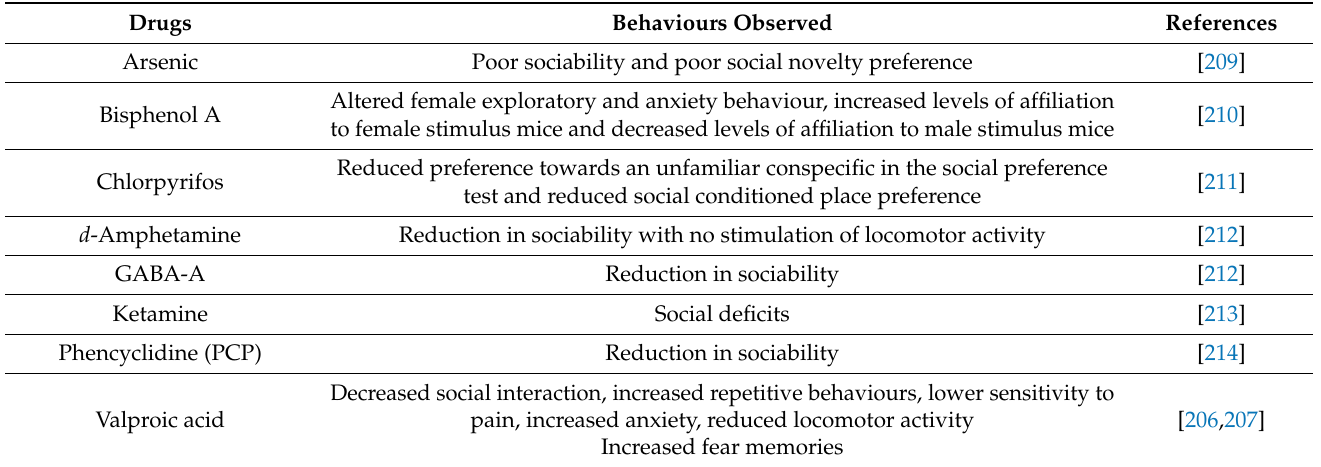
Table 7. Main chemicals used to induce ASD in mouse models. Chemicals are used to induce ASD behaviours in